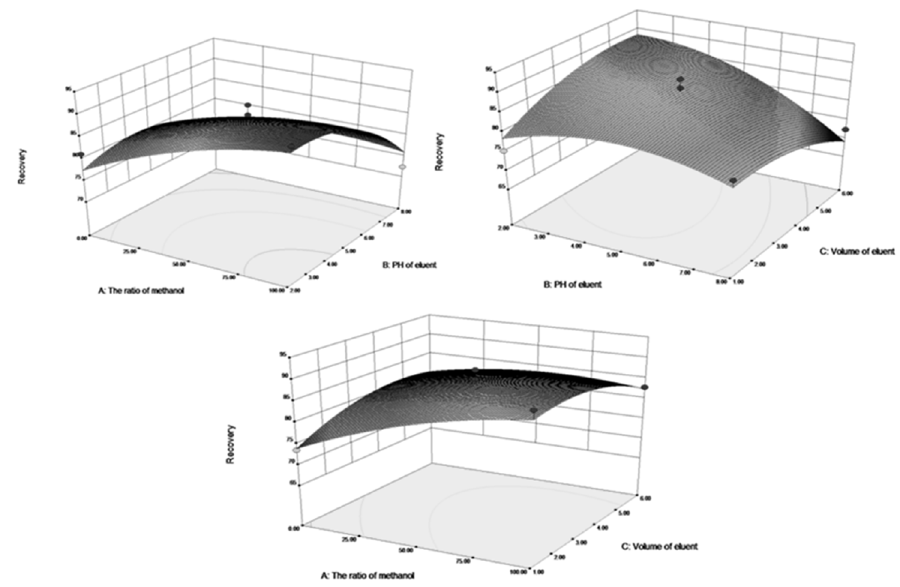
Figure 7. Effects of ratio of metanol, PH of eluent, volume ofeluent, and their reciprocal 3D response interaction on recoveries for theobromine with DES-7-Fe 3 O 4 /MIPs in SPE.